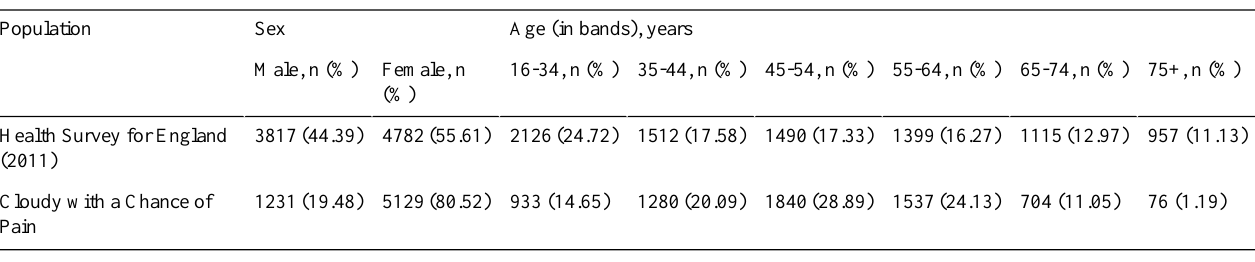
Table 2. Comparison of the sex and age distribution of persons with chronic pain from the Health Survey for England (2011) and participants recruited to Cloudy with a Chance of Pain.